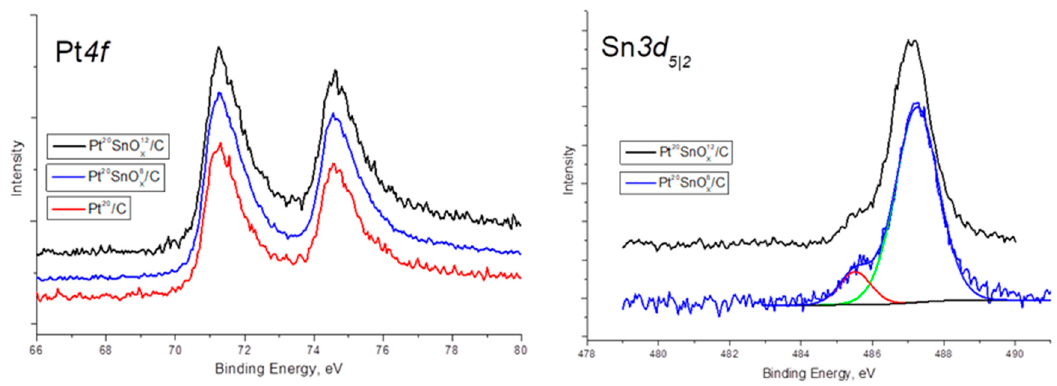
Figure 3. Both Sn 3d 5/2 and Pt 4f XPS profiles of the Pt 20 /C (only Pt 4f), Pt 20 /SnO x8 /C and Pt 20 /SnO x12 /C.